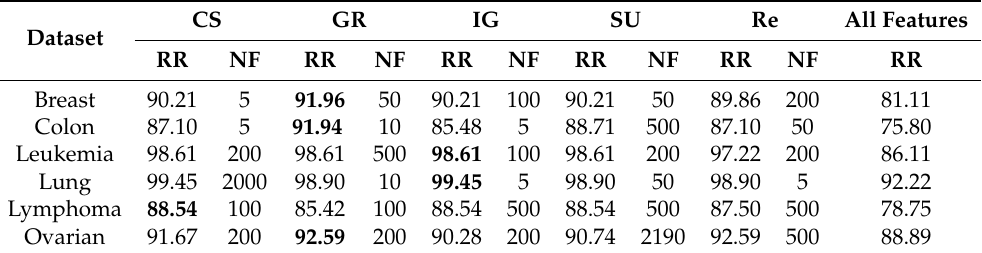
Table 6. Best results of ranking-based feature-selection methods with kNN classifier. Dataset